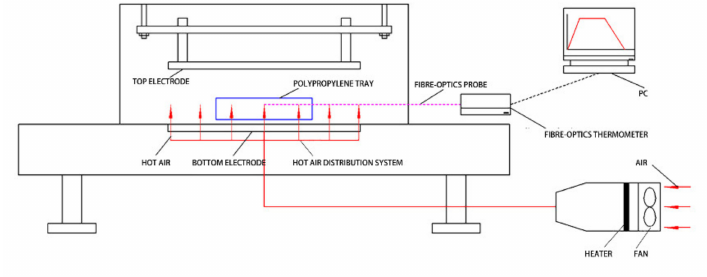
Figure 1. RF–hot air combined drying system.